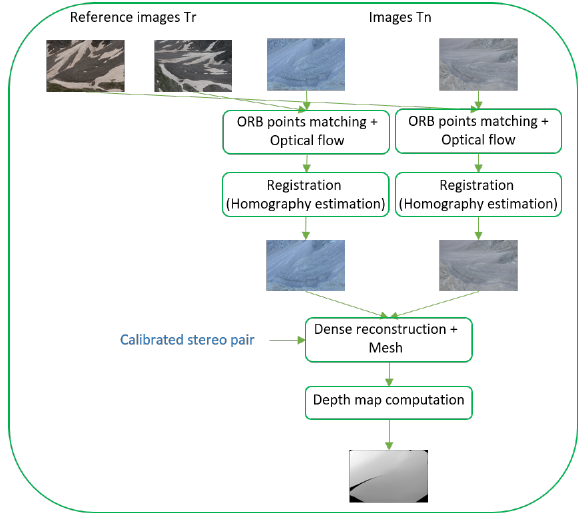
Figure 2. Depth map pipeline: first the images are registered on the stereo pair on which the calibration has been done. The registration is done by extracting corresponding pixels in fixed areas and use them to estimate an homography. Then structure from motion methods are used to produce 3D models and